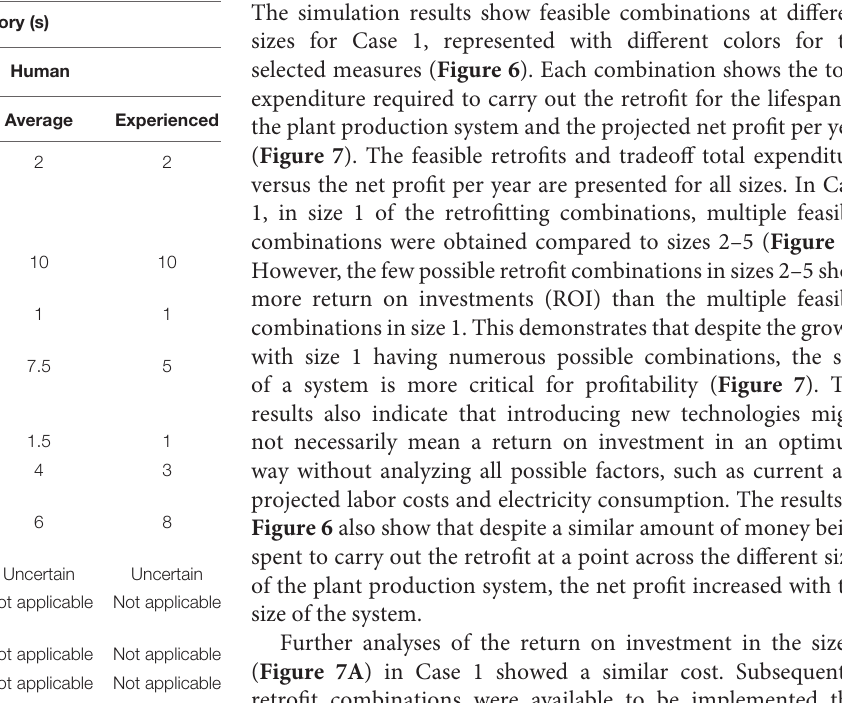
TABLE 3 | Comparison between humans and robots in strawberry